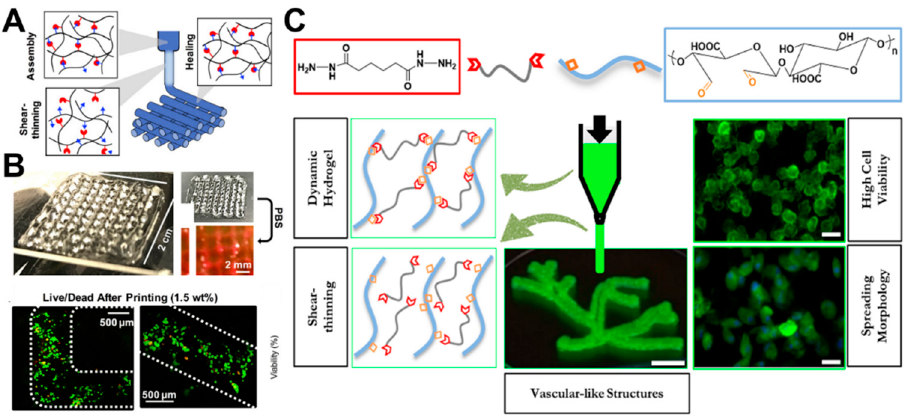
Figure 10. ( A ) Schematics for shear-thinning and self-healing of hydrogels during printing, where the hydrogels were formed in syringes, and filaments were stabilized by the self-healing properties of hydrazone bonds through shearing during the extrusion process. ( B ) Photos of 4-layer lattices in air and in PBS. ( C ) Live/dead staining of cells in lattice filaments immediately after extrusion. Reprinted with permission [50]. © 2018, Wiley-VCH (Weinheim, Germany). ( D ) The schematic diagram for the chemical structure and advantages of the bioprintable hydrogels [36] .